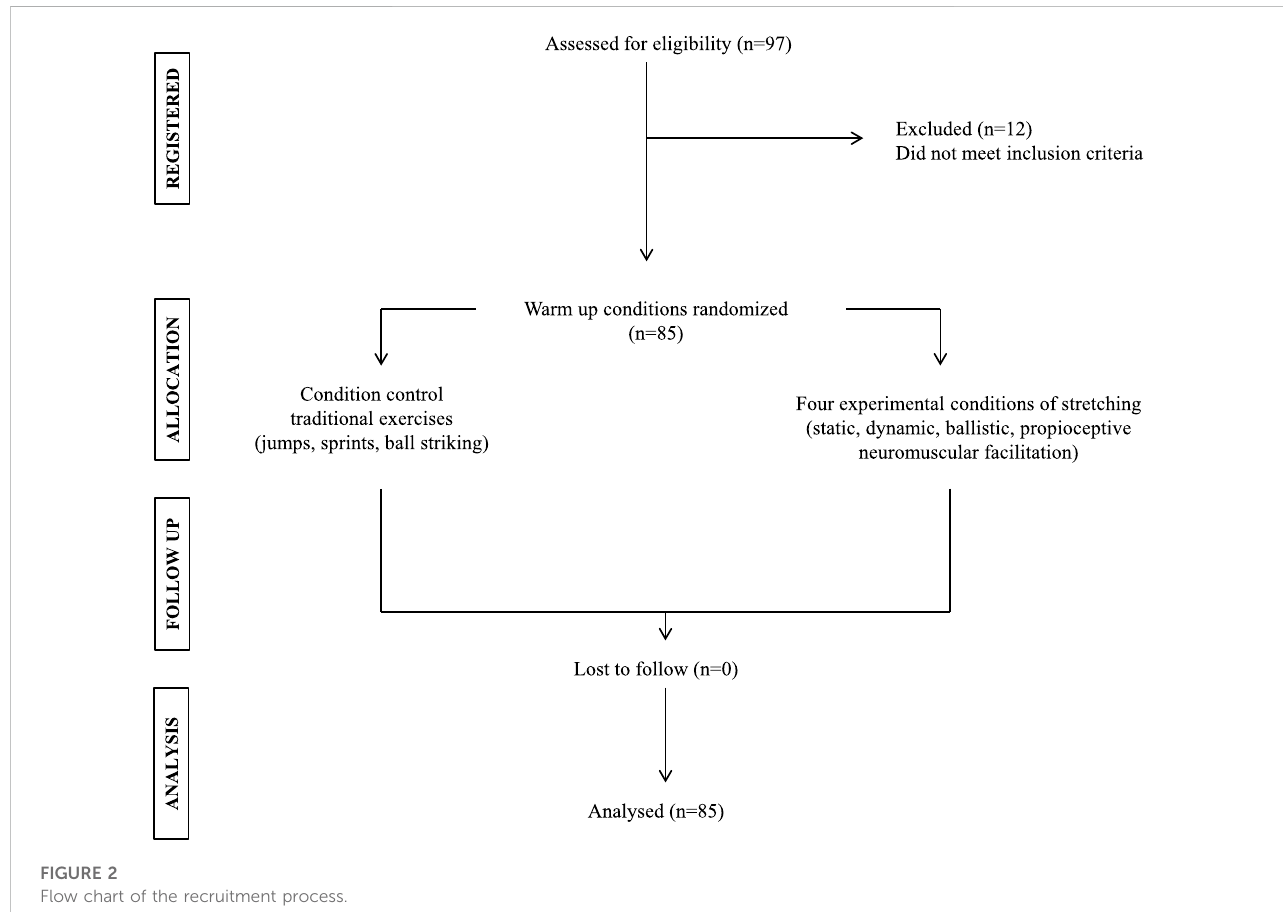
FIGURE 2 Flow chart of the recruitment